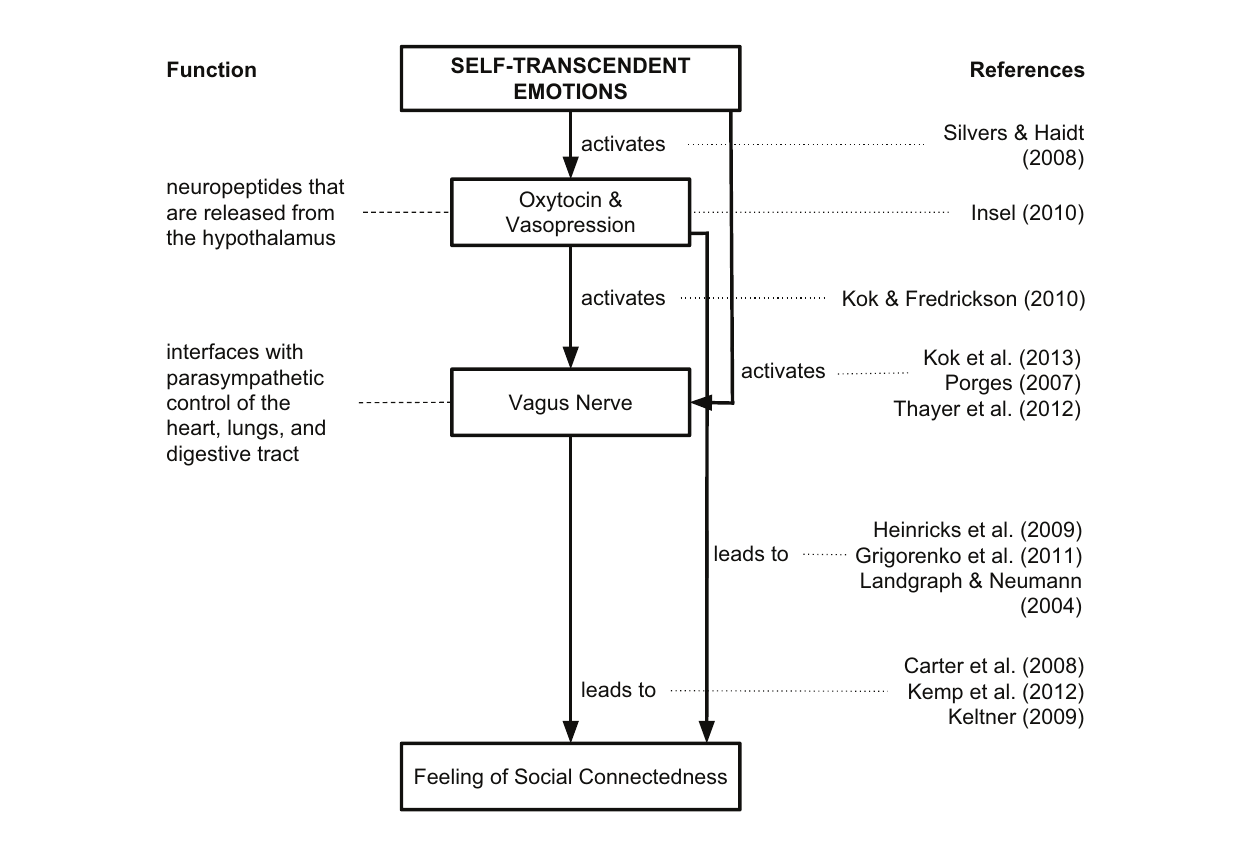
FIGURE 4 | Biochemical processes related to self-transcendence. For a review, see (Yaden et al.,